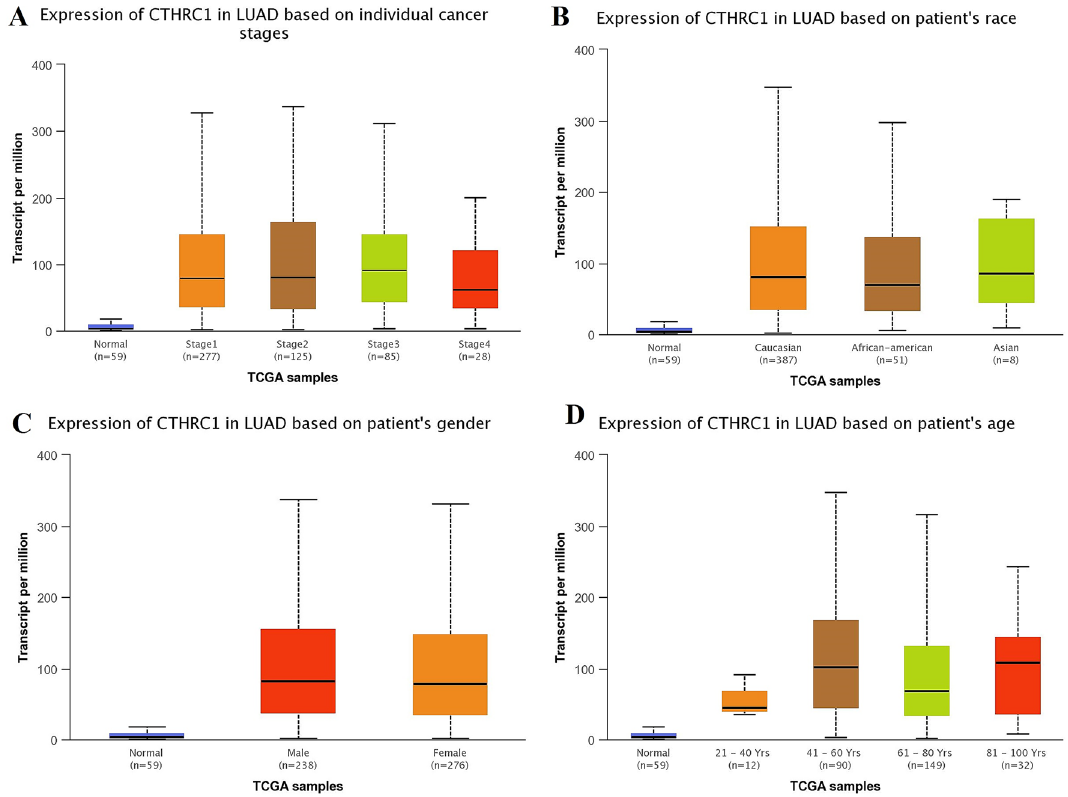
Figure 7. CTHRC1 transcription in various clinicopathological parameters of LUAD. ( A ) Different cancer stages based, ( B ) Different patients race based, ( C ) Different patients gender based, and ( D ) Different age groups based. A p-value of < 0.05 was selected as a cutoff